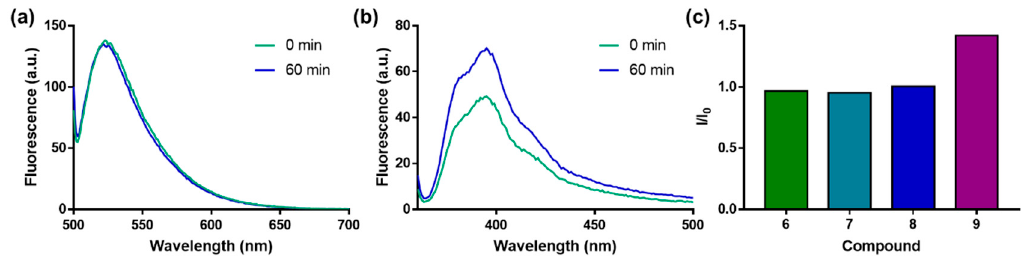
Figure 4. The influence of complete cleavage by hDcpS (30 nM) on the fluorescence properties of probes 6 – 9 (100 nM). Emission spectra before (0 min) and after (60 min) decapping scavenger (DcpS) cleavage for compounds 6 ( a ) and 9 ( b ); ( c ) The ratios of fluorescence intensity after and before cleavage (I/I 0 ) for all studied probes.